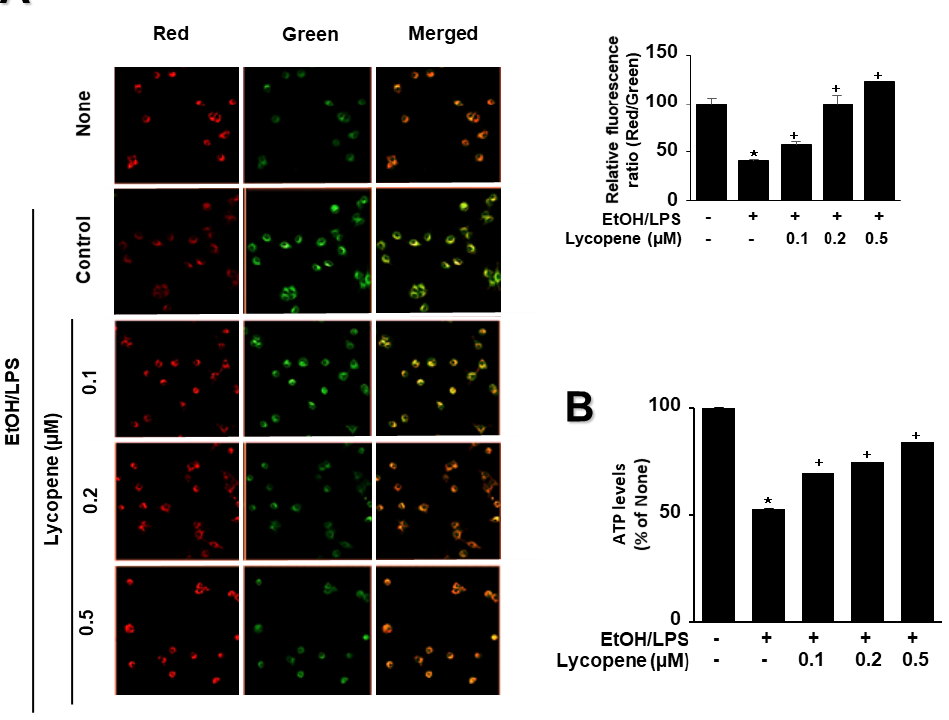
Figure 4. Effect of lycopene on ethanol (EtOH)/lipopolysaccharides (LPS)-induced decrease in mitochondrial membrane potential (MMP) and ATP levels in AR42J cells. Cells (2 × 10 5 /2 mL/well) were pretreated with the indicated concentrations of lycopene for 1 h, and subsequently stimulated with EtOH (at a final concentration of 250 mM)/LPS (10 μg/mL) for 30 min. ( A ) The cells were stained with JC-1 dye and visualized with a confocal laser scanning microscope (left panel). The MMP was determined by measuring the intensity of red emission relative to the intensity of green emission (right panel). A decrease in the red/green fluorescence intensity ratio indicates mitochondrial depolarization. Data are expressed as the mean ± SE ( n = 3 in each group). ( B ) ATP levels were quantified using luminescent ATP substrate. The ATP concentration was determined by interpolating within the ATP standard reference. The fluorescence ratio or ATP level in control cells (cells not treated with EtOH/LPS or lycopene) was set as 100%. Data are expressed as the mean ± SE ( n = 12 in each group). * p < 0.05 vs. control cells (cells not treated with EtOH/LPS and lycopene); + p < 0.05 vs. stimulated cells without lycopene (cells treated with EtOH/LPS and without lycopene). AR42J cells incubated with tetrahydrofuran (THF, 0.01%) alone served as a vehicle control. For each experiment, lycopene-untreated cells received a vehicle THF (0.01%) alone instead of lycopene. +, treatment.